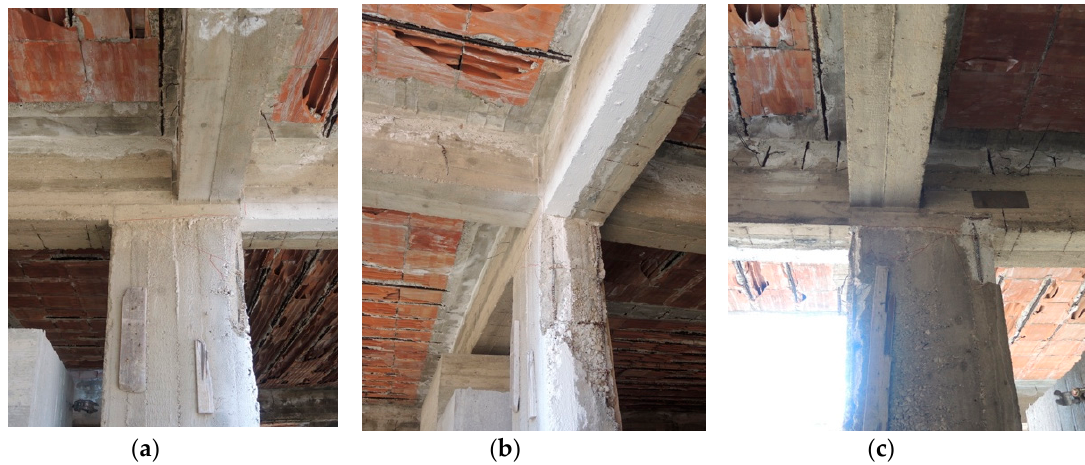
Figure 17. Run #9, 62.4 mm—1.69%: Damage at the top of column c5. Front ( a ), side ( b ) and back ( c ) view. Buildings 2020 , 10 , x FOR PEER REVIEW